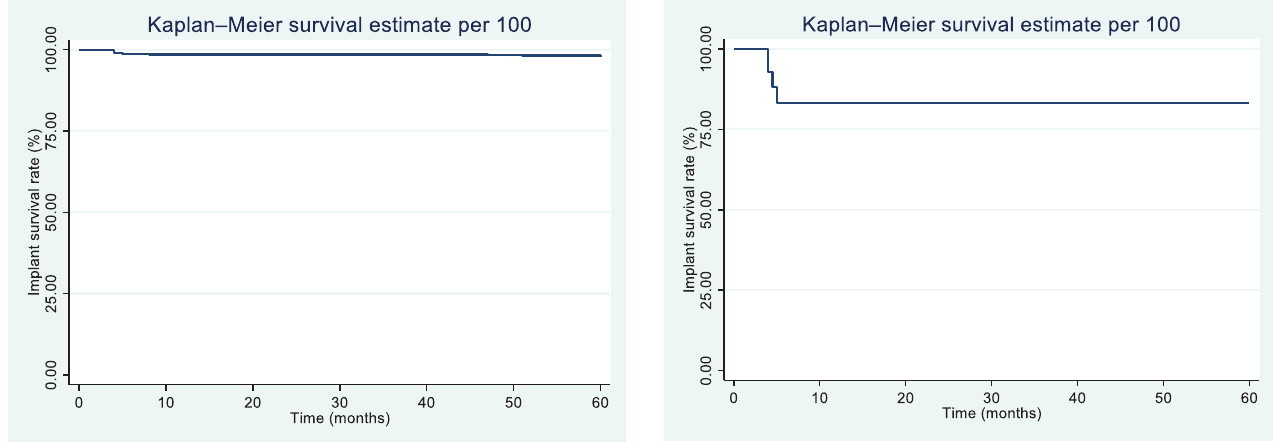
Fig. 4. Kaplan Meier implant survival curve showing the success rate of the 5-years for all implants with zero insertion torque.